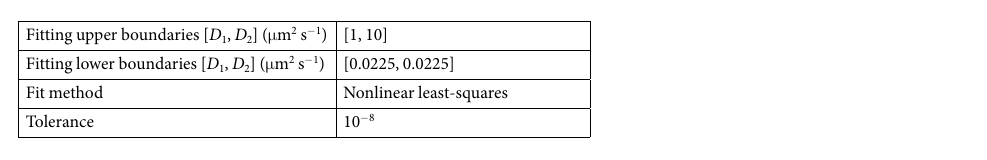
Table 2. Configuration of the fitting